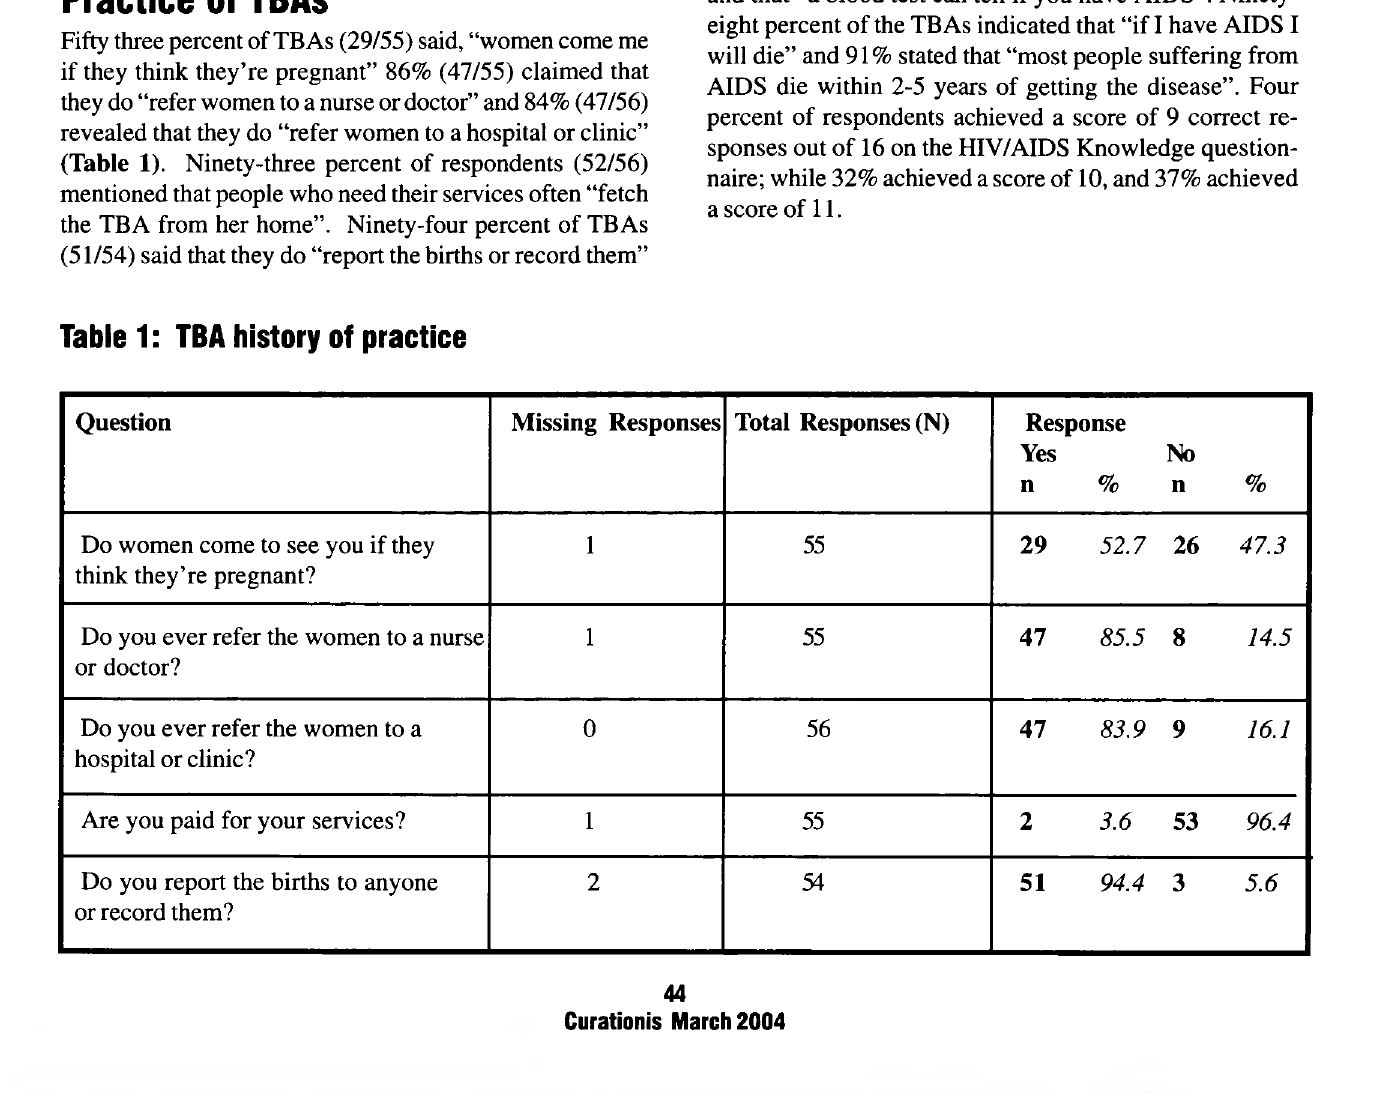
Table 1: TBA history of